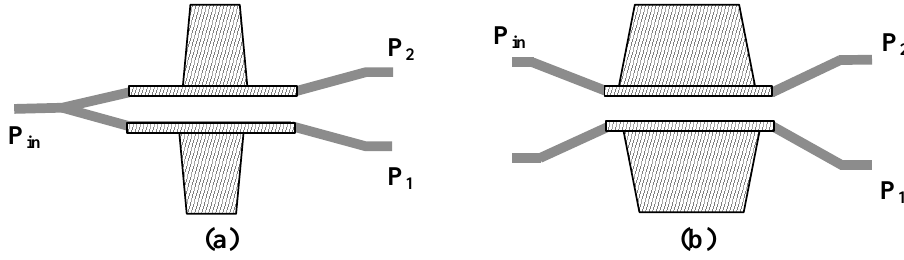
Figure 11. CI-based IOES with three ports and four ports